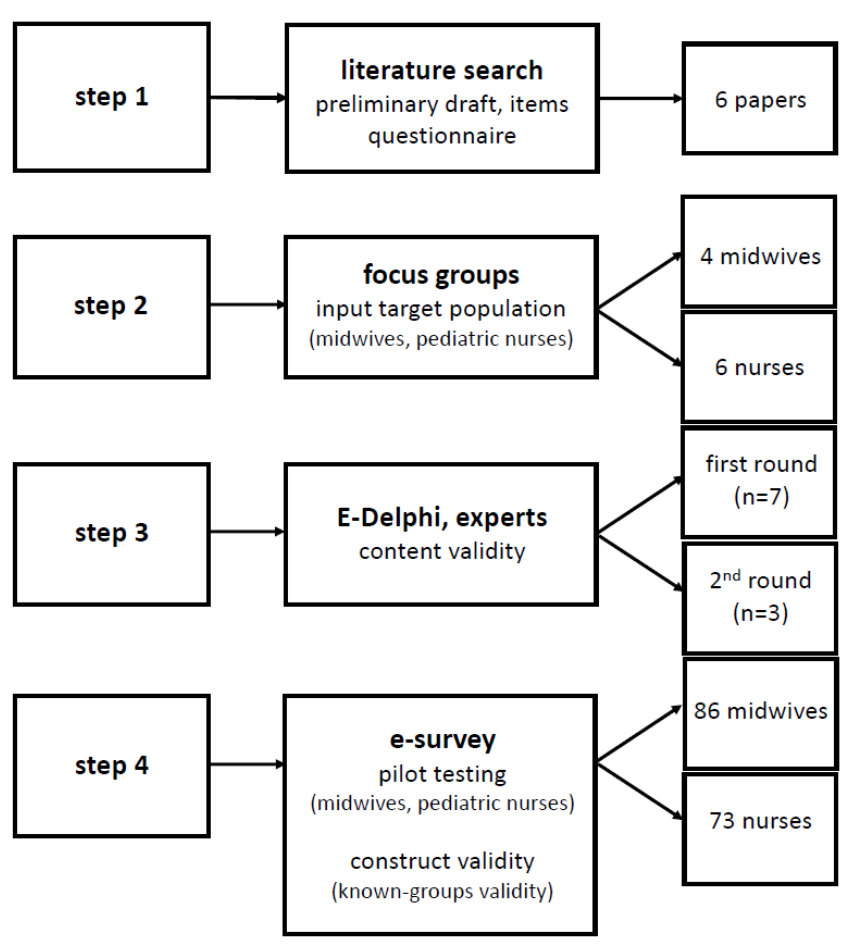
Figure 1. Workflow of the development and testing of the instrument.